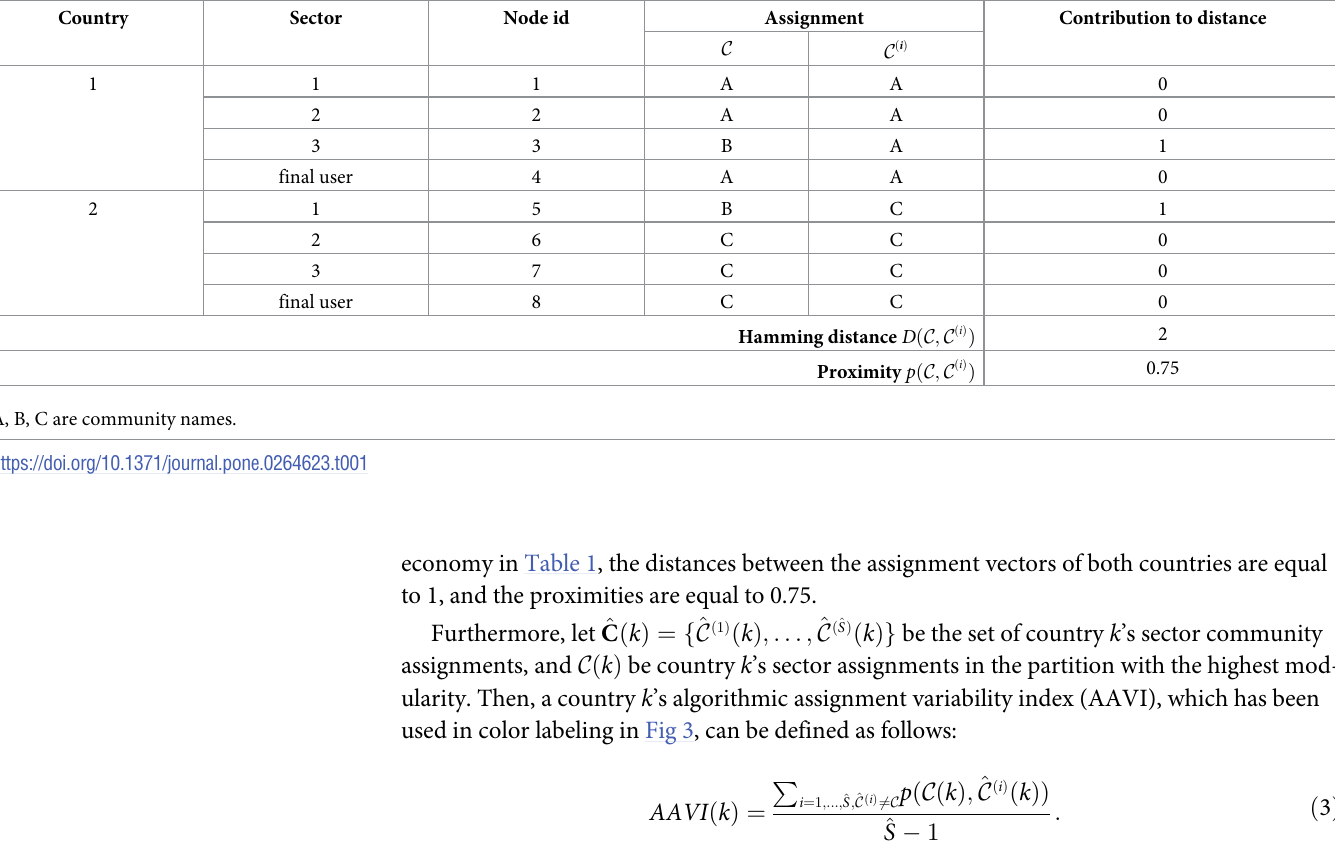
Table 1. Example of the calculation of the Hamming distance and proximity between to different partitions for the two-country the-sector world economy.